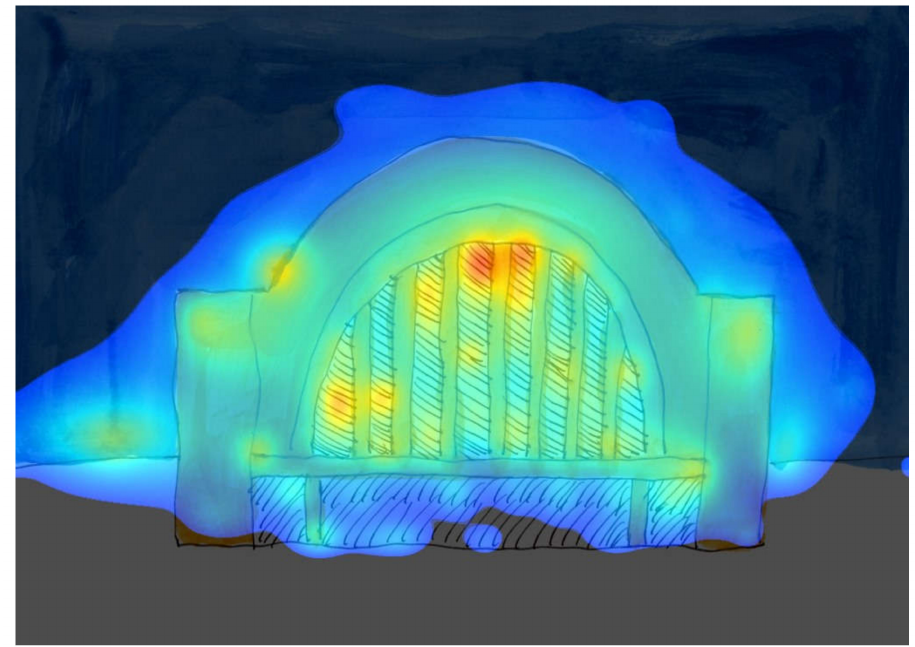
Figure 4. Heat map for Art Deco